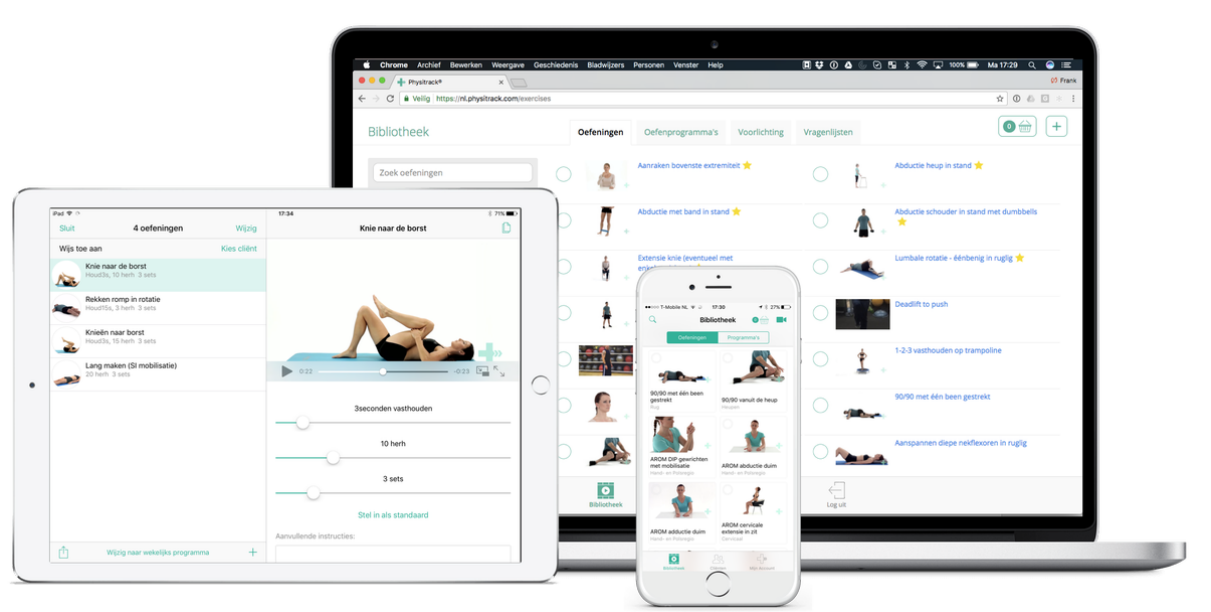
Figure 1. Goal-oriented exercise program created by the physiotherapist, accessible by tablet, mobile phone, or computer (Used with permission from